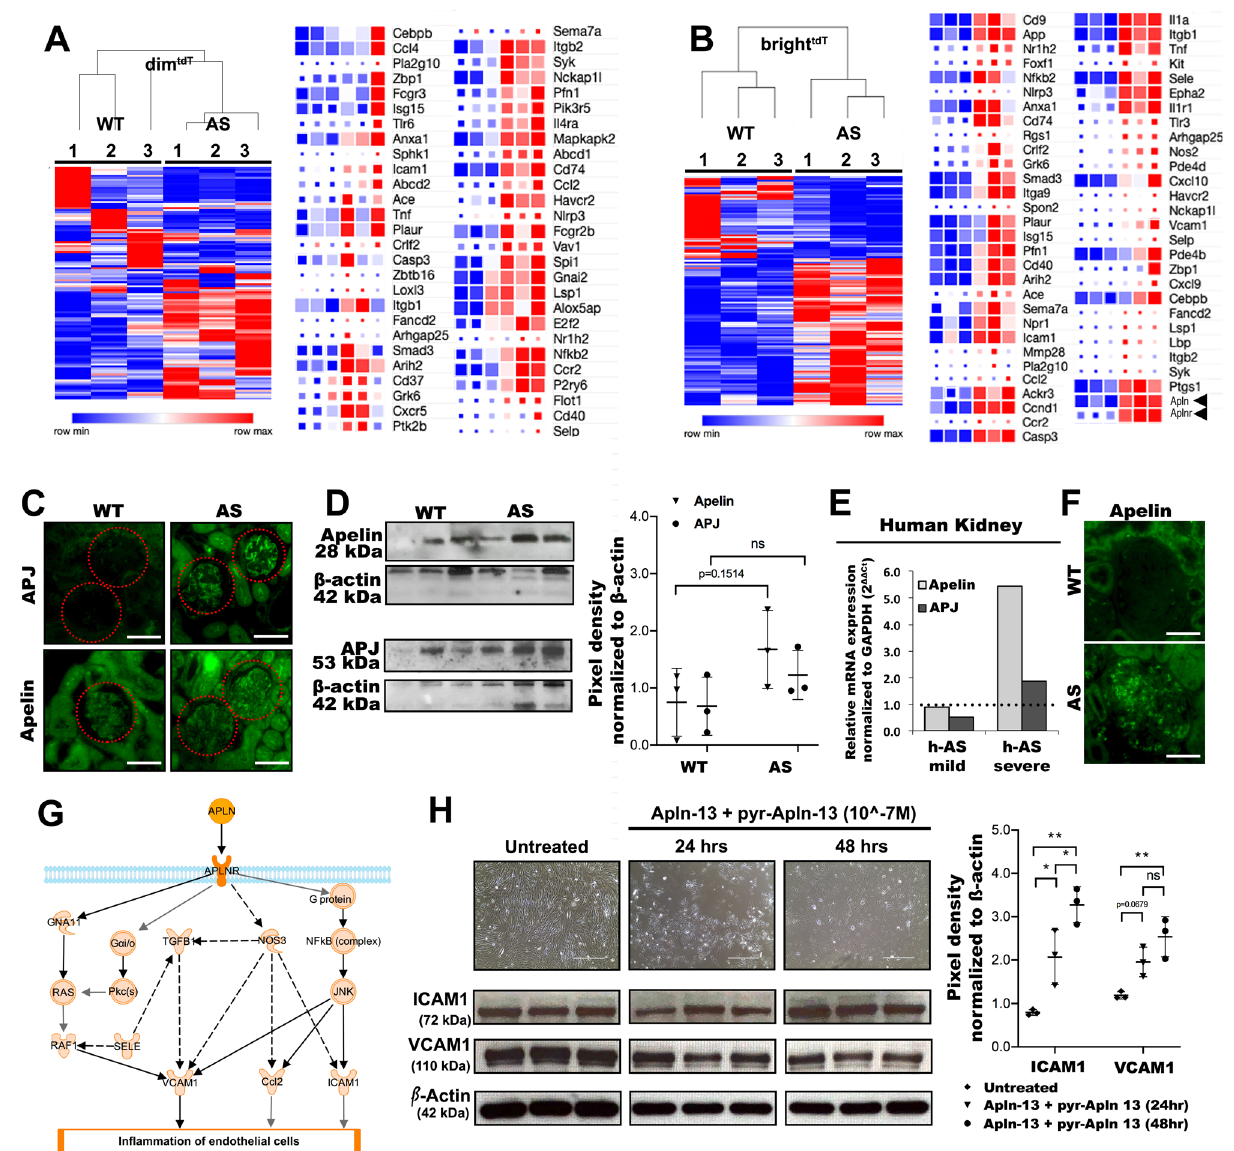
Figure 6. Inflammatory profile of GEC subpopulations in AS and the role of Apelin signaling. ( A, B) Heatmap diagrams with color-coded representation of RPKM values comparing the gene expression of inflammatory markers in AS dim tdT ( A ) and AS bright tdT GEC ( B ) and their wild type counterparts (biological replicates, n = 3 mice/group). Genes of significance and with high differential expression are listed next to the diagram. The color scale represents relative gene expression levels across each row with red denoting upregulation and blue denoting downregulation. Color intensity indicates stronger regulation. ( C) Representative immunofluorescence images of glomeruli from WT and AS kidney sections stained for Apelin and APJ show increased expression (green signal) in the AS. ( D) Representative immunoblots comparing protein expression for Apelin (28 kDa) and APJ (53 kDa) in GEC between WT and AS mice normalized against β-actin (42 kDa). Densitometric analysis of the immunoblots is shown in dot plots as pixel density measurements, (biological replicates, n = 3/ group). € Bar graphs showing RT-qPCR analysis and relative expression of Apelin and APJ gene expression in human kidney tissue samples from AS patients with low and high level of proteinuria (AS-mild patient (n = 1): 17 years male, proteinuria: 2.5 g/day; AS-severe patient (n = 1): 22 years male, proteinuria: 10 g/day) as compared to a healthy donor and normalized to GAPDH according to the 2 ∆∆Ct method. ( F) Representative immunofluorescence images of human kidney sections showing increased expression for Apelin (green signal) in the AS glomeruli compared to healthy control. ( G) Apelin/APJ signaling cascade that leads to the activation and upregulation of pro-inflammatory genes. ( H) Apelin-13 induces expression of inflammatory markers in human primary GEC. 2.5 × 10^5 human primary GEC were co-treated with 10 -7 M apelin-13 and pyr-apelin-13 isoforms simultaneously for 24 and 48 h or were left untreated (control). Representative brigt-field light microscopy images show significant cell detachment and changes in cell morphology post treatment, while representative immunoblots show the time-dependent expression of ICAM1 (72 kDa) and VCAM1 (110